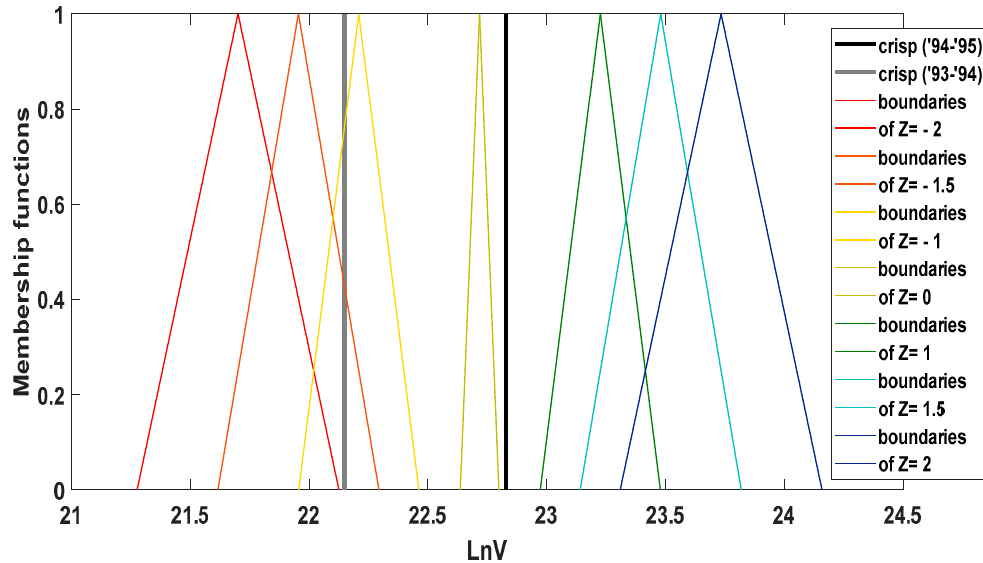
Figure 5. Fuzzy thresholds of drought regarding the values of Z (presented in Table 1) and the (crisp) annual cumulative discharge for the hydrological year, 94–95 and